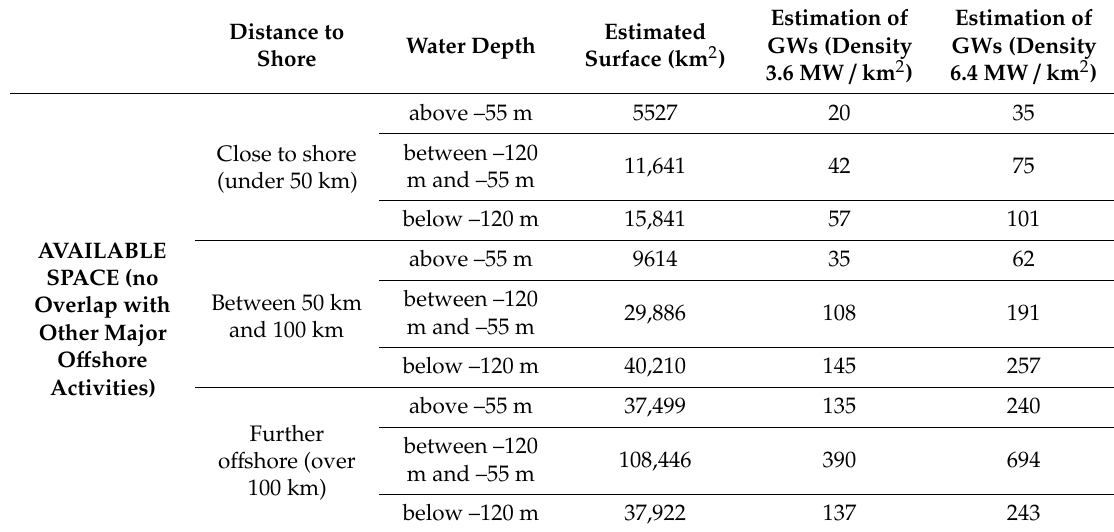
Table 13. Available space—Scenario D.